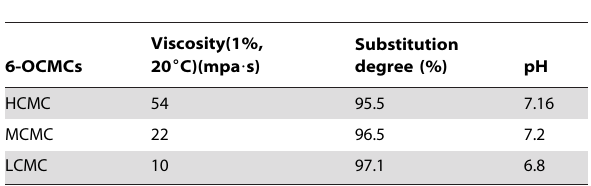
Table 2. Physicochemical properties of various